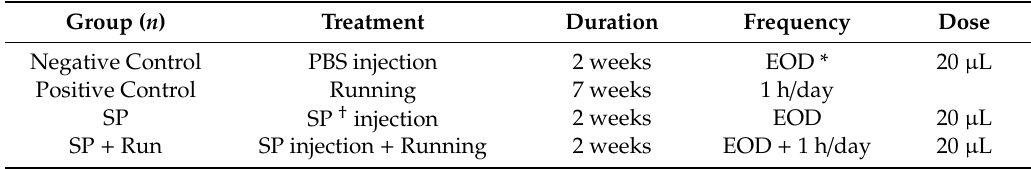
Table 1. Animal groups and